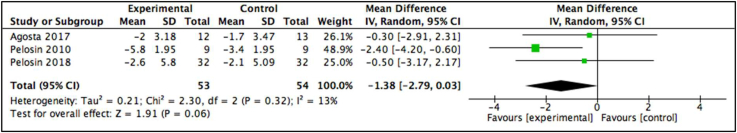
Pooled analysis for the FOG Questionnaire in patients with Parkinson disease.